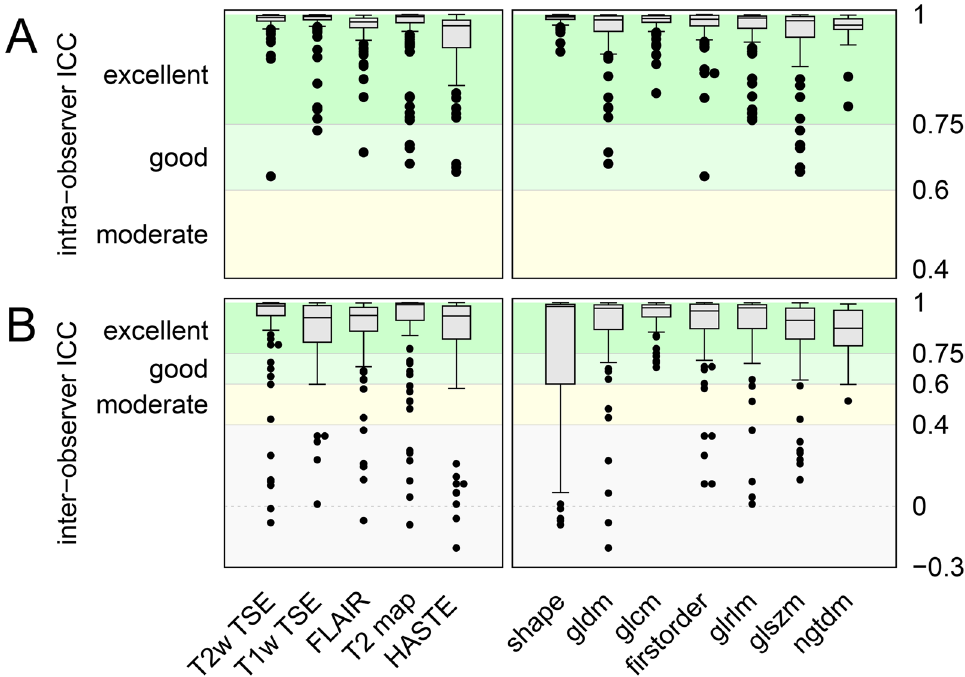
Figure 3. Inter-observer variance highly influences shape features. Box-Whisker plots for intraclass correlation coefficients are depicted (5–95 percentile) to visualize intra- ( A ) and inter-observer ( B ) reproducibility. To comprehensively visualize the effect of each feature, we performed single feature analysis with regard to the MRI sequence (left part) and feature class (right part) with outliers being depicted as dots ( A , B